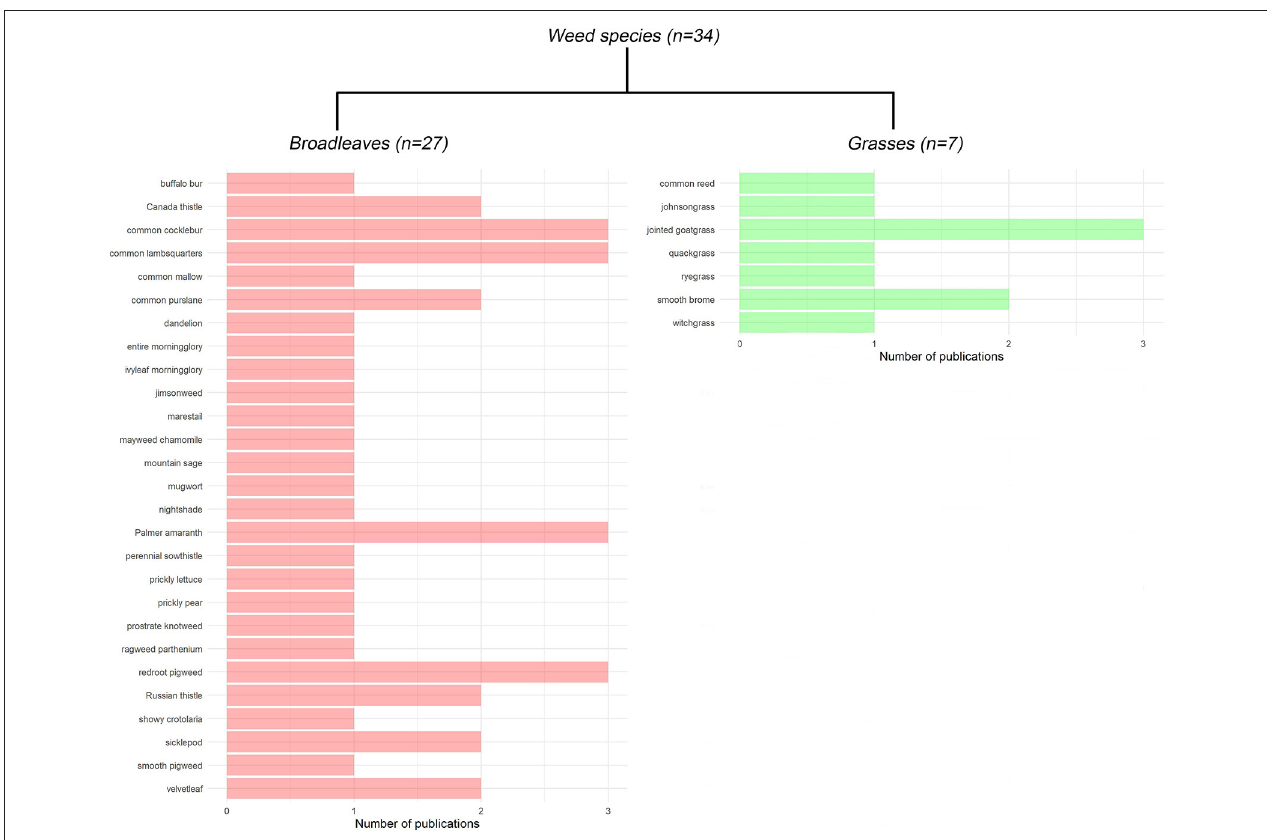
FIGURE 3 | The total number of publications reporting the water use (WU) of broadleaf and grass weed